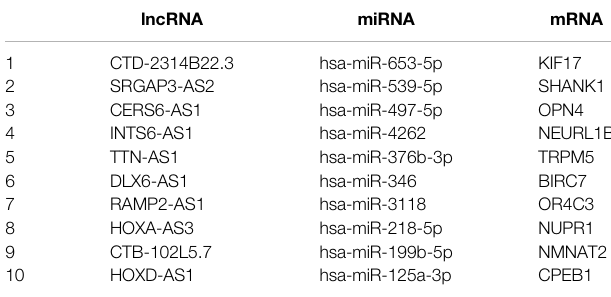
TABLE 6 | CeRNA (long non-coding RNA [lncRNA]-micro RNA [miRNA]- messenger RNA [mRNA]) prediction score analysis using the integrated